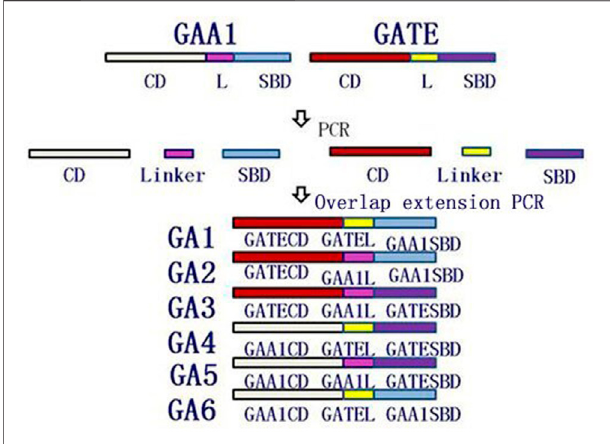
FIGURE 1 | Schematic of creating recombinant glucoamylase genes GA1 – GA6 by domain shuf fl ing using the overlap extension PCR. CD, linker, andSBDfragmentsfromGAA1andGATEgeneswere,respectively,ampli fi ed by PCR and were used as templates of the overlap extension PCR to amplify GA1 – GA6